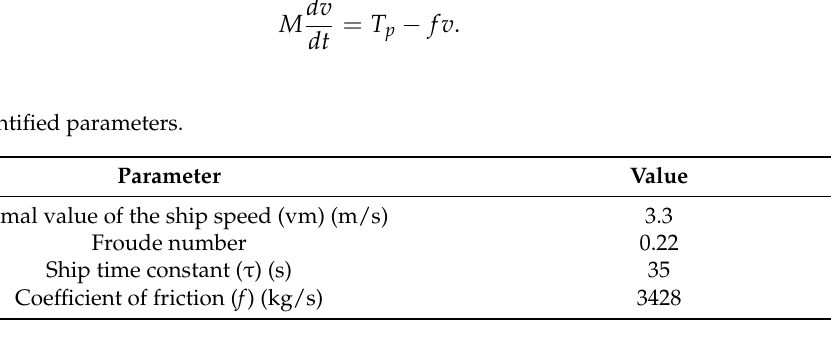
Coefficient of friction ( f ) (kg/s) 3428